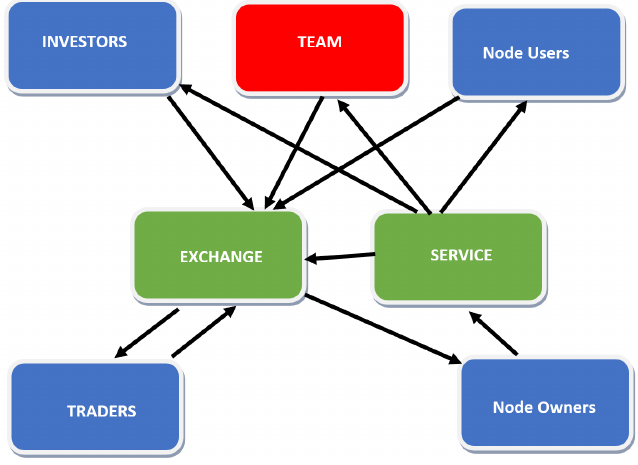
Figure 1. The token movement between